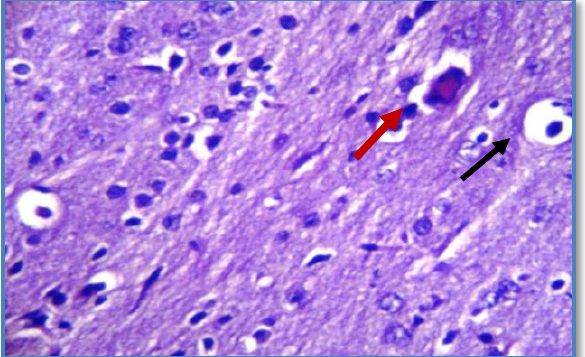
Figure, 1:Histopathological section in the brain (cerebrum) of mice injected I/P with 0.1 ml of suspension of digested organs at day 15 showing perivascular ( ) and perineuronal edema ( ) H and E 40.